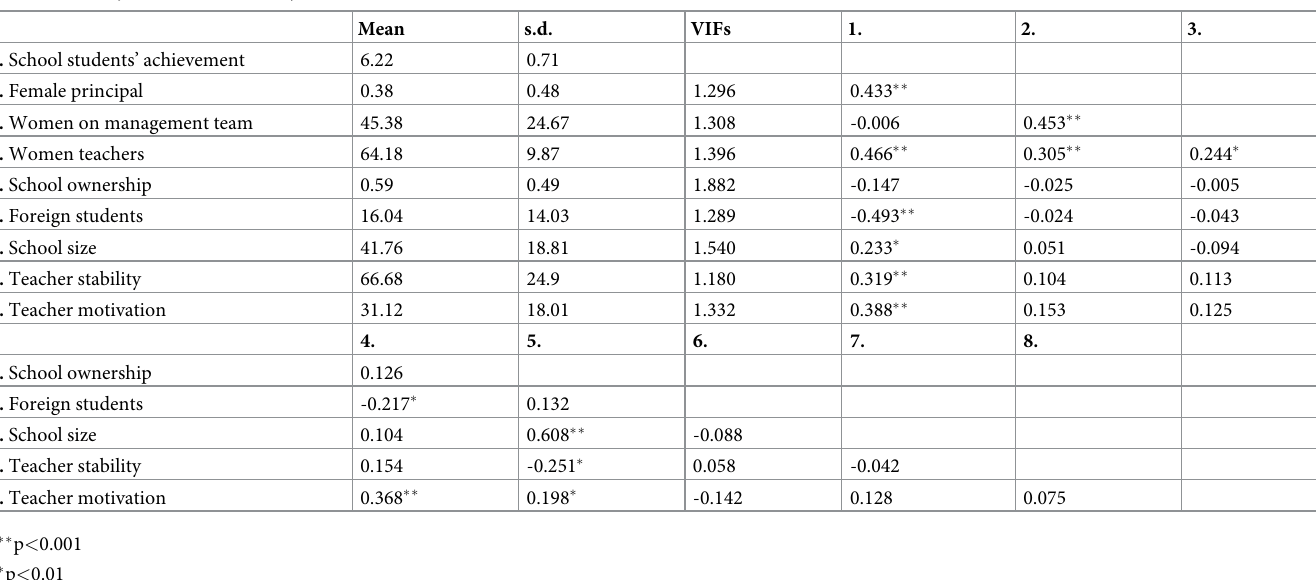
Table 1. Means, standard deviations, variance inflation factors and